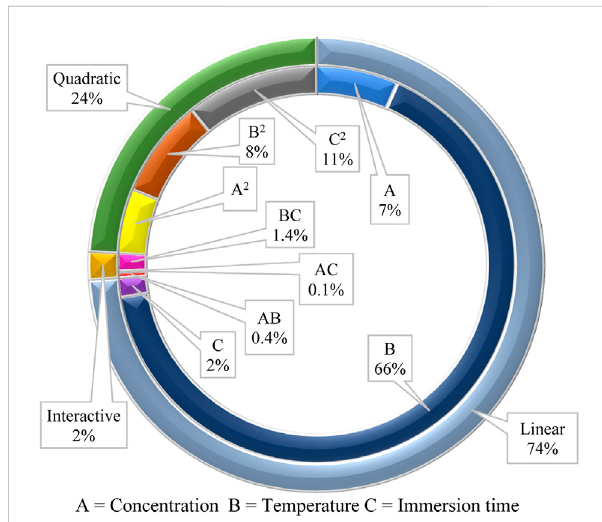
FIGURE 10 In fl uence of various factors in linear, interactive, and quadratic terms on corrosion inhibition ef fi ciency of okra mucilage